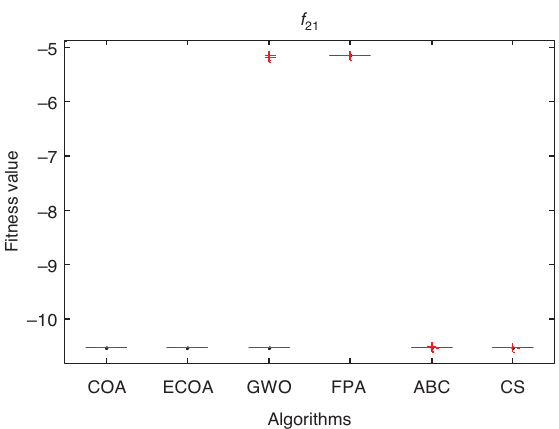
Figure 42: D = 4, ANOVA Test of Global Minimum for f